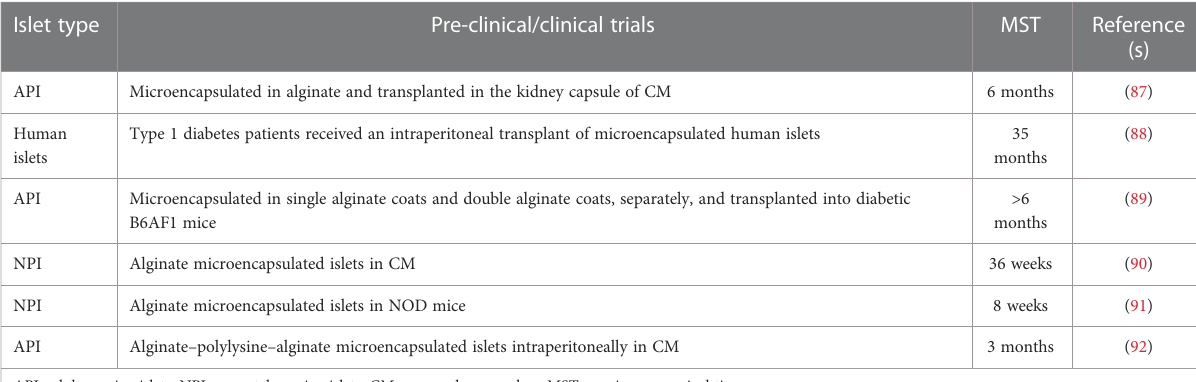
TABLE 4 Devices containing microencapsulated islets used in various preclinical and clinical trials.